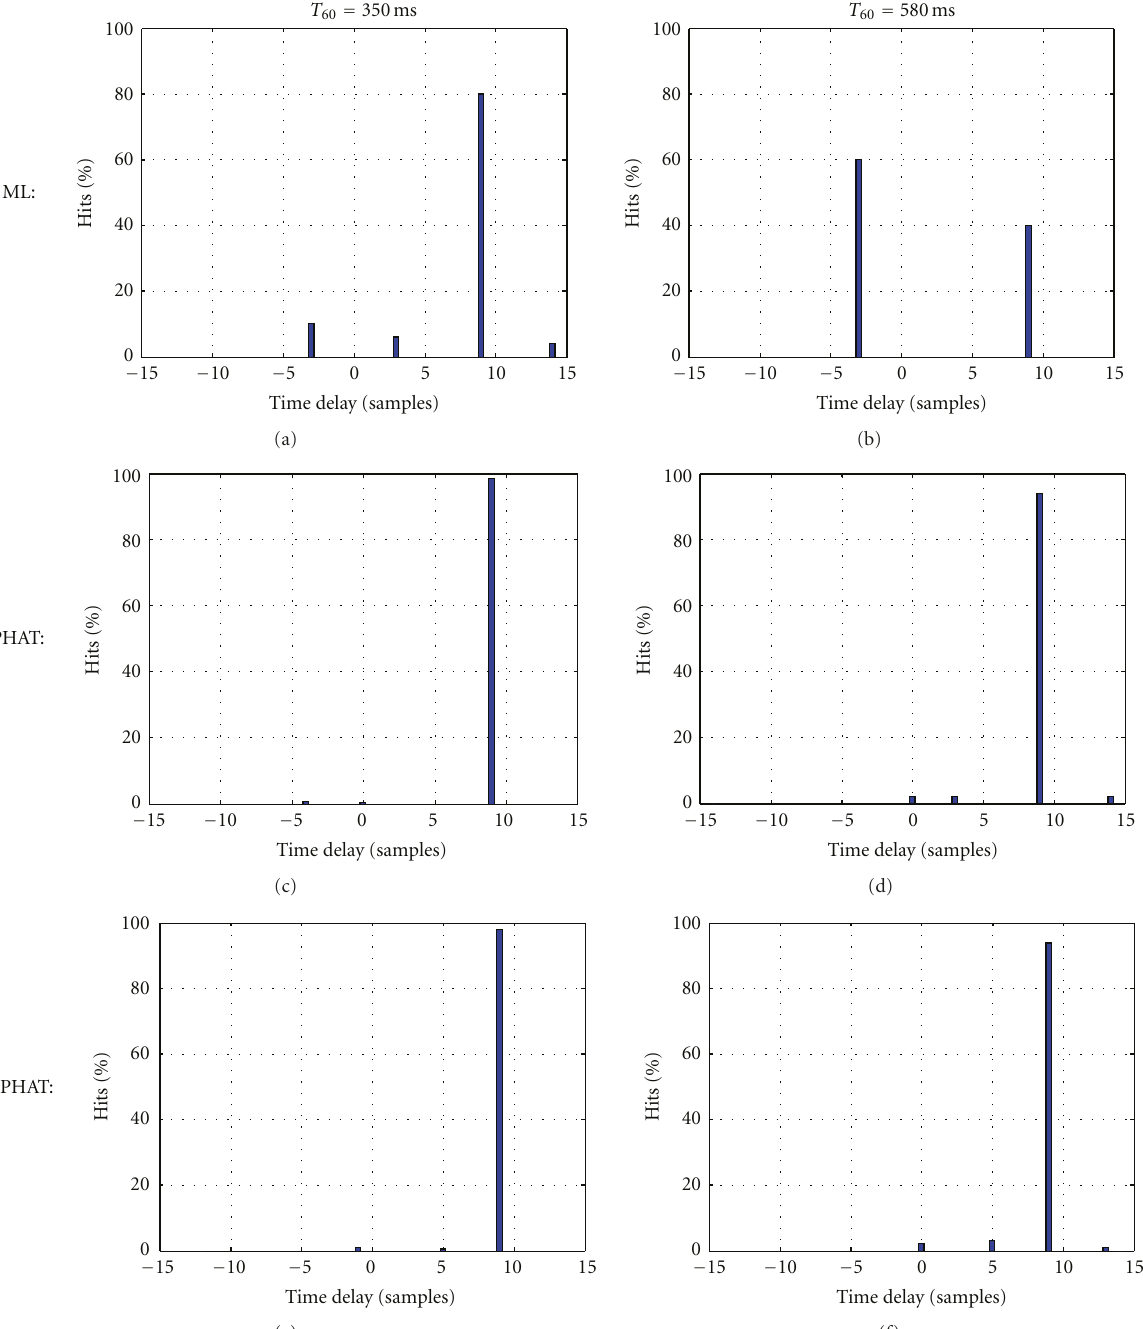
Figure 3: TDE performance in reverberant situations (exact value of TDOA is 9